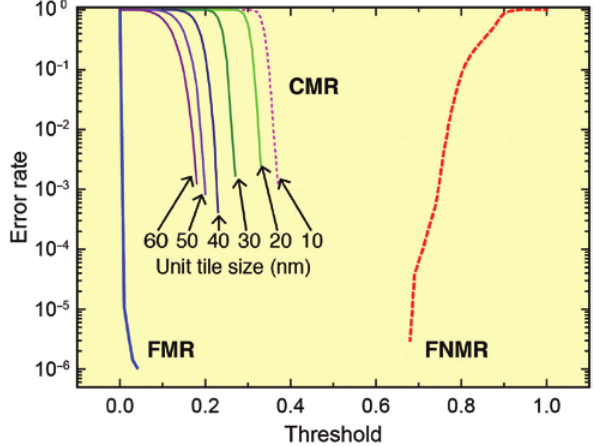
Figure 2: Quantitative evaluation of the security performance of nanoscale artifact metrics according to the FMR, FNMR, and CMR. Source: Adapted with permission from Macmillan Publishers Ltd: Scientific Reports